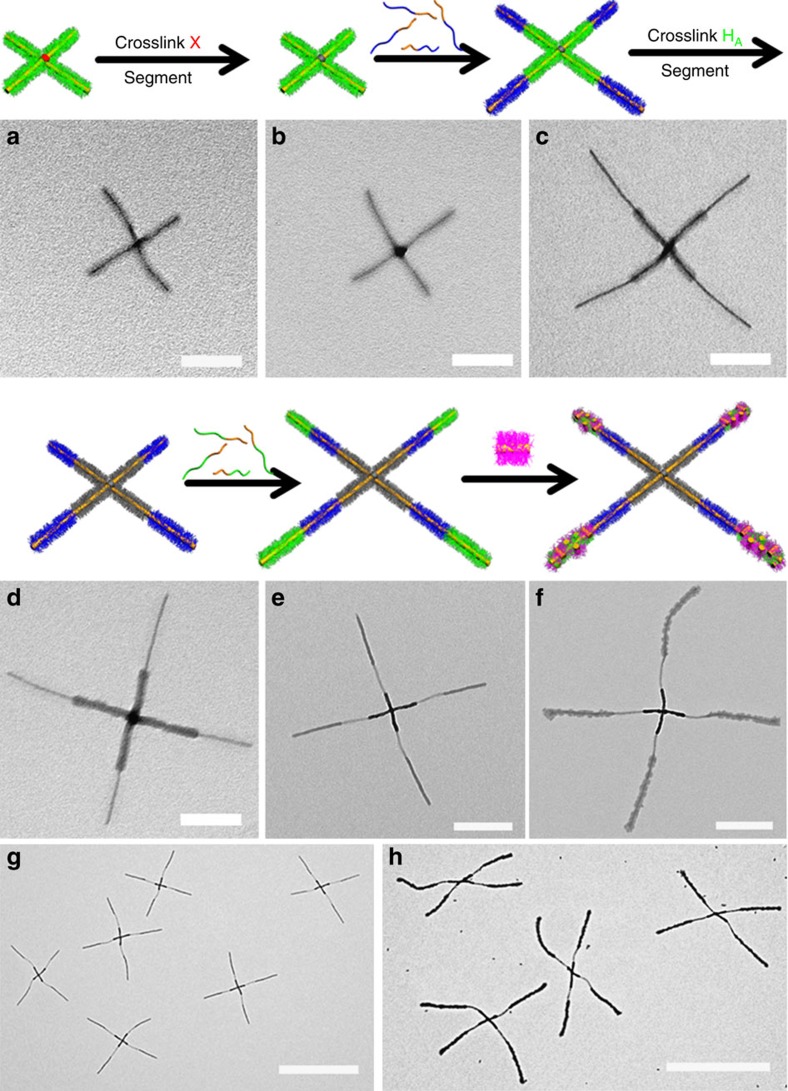
Programmed stepwise hierarchical assembly.TEM images (after solvent evaporation) and corresponding schematic representations of (a) ‘cross' supermicelles from the HA-X-HA (420 nm) triblock comicelles; and the ‘cross' supermicelles (b) with crosslinked XLX segments; (c) after the growth of N segments; (d) with crosslinked XLHA segments; (e) after the growth of another HA segments; and (f) after the further addition of HD seed micelles in i-PrOH. Scale bars are 200 nm in images a–d, 500 nm in images (e,f) and 2 μm in lower magnification images (g,h). Segment X=M(PFS36-b-PMVS324), HA=M(PFS25-b-P2VP250), N=M(PFS20-b-PtBA280) and HD=M(PFS20-b-PMVSOH120).